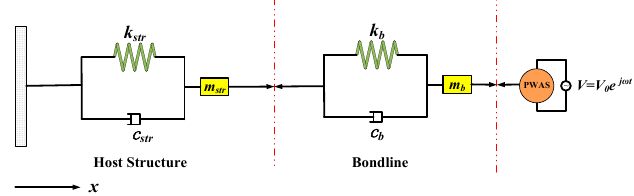
Figure 7. SMD equivalent model considering bondline.